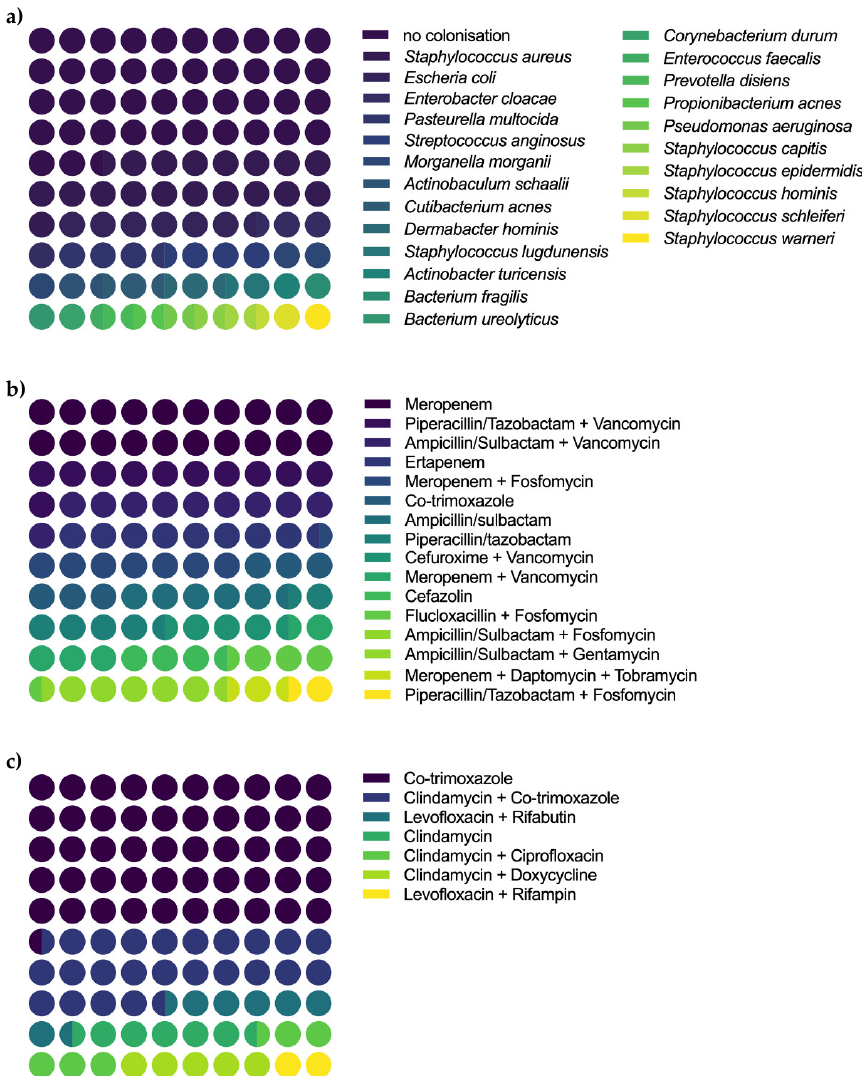
Figure 1. Colonization in microbiologic samples and intravenous and oral antibiotic regimes. ( a ) Depicts the microbiologic results of intraoperative assessment of deep tissue samples. There was no colonization in 47/110; Staphylococcus aureus in 20/110; Escherichia coli in 7/110, Enterobacter cloacae , Pasteurella multocida and Streptococcus anginosus in 4/110; Morganella morganii in 3/110, Actinobaculum schaalii , Cutibacterium acnes , Dermabacter hominis and Staphylococcus lugdunensis in 2/110 and Actinobacter turicensis , Bacterium fragilis , Bacterium ureolyticus , Corynebacterium durum , Enterococ- cus faecalis , Prevotella disiens , Propionibacterium acnes , Pseudomonas aeruginosa , Staphylococcus capitis , Staphylococcus epidermidis , Staphylococcus hominis , Staphylococcus schleiferi, or Staphylococcus